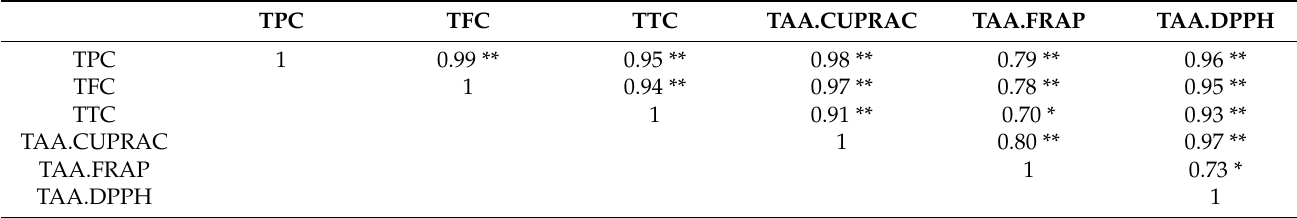
Table 2. Pearson correlation coefficients among TPC, TFC, TTC, and total antioxidant activity (CUPRAC, FRAP, and DPPH) of C. polygonoides L. foliage at twelve sampling